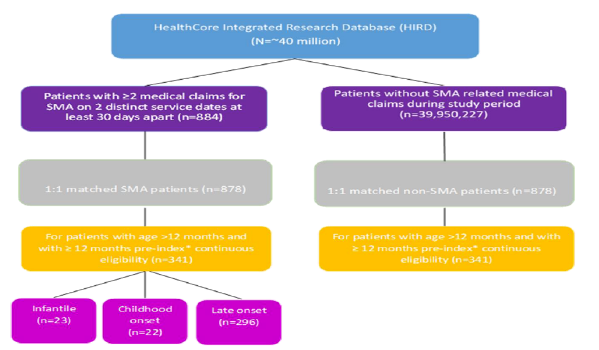
Figure 1. PFigure 1. Patient Floatient Flow Chartw Chart